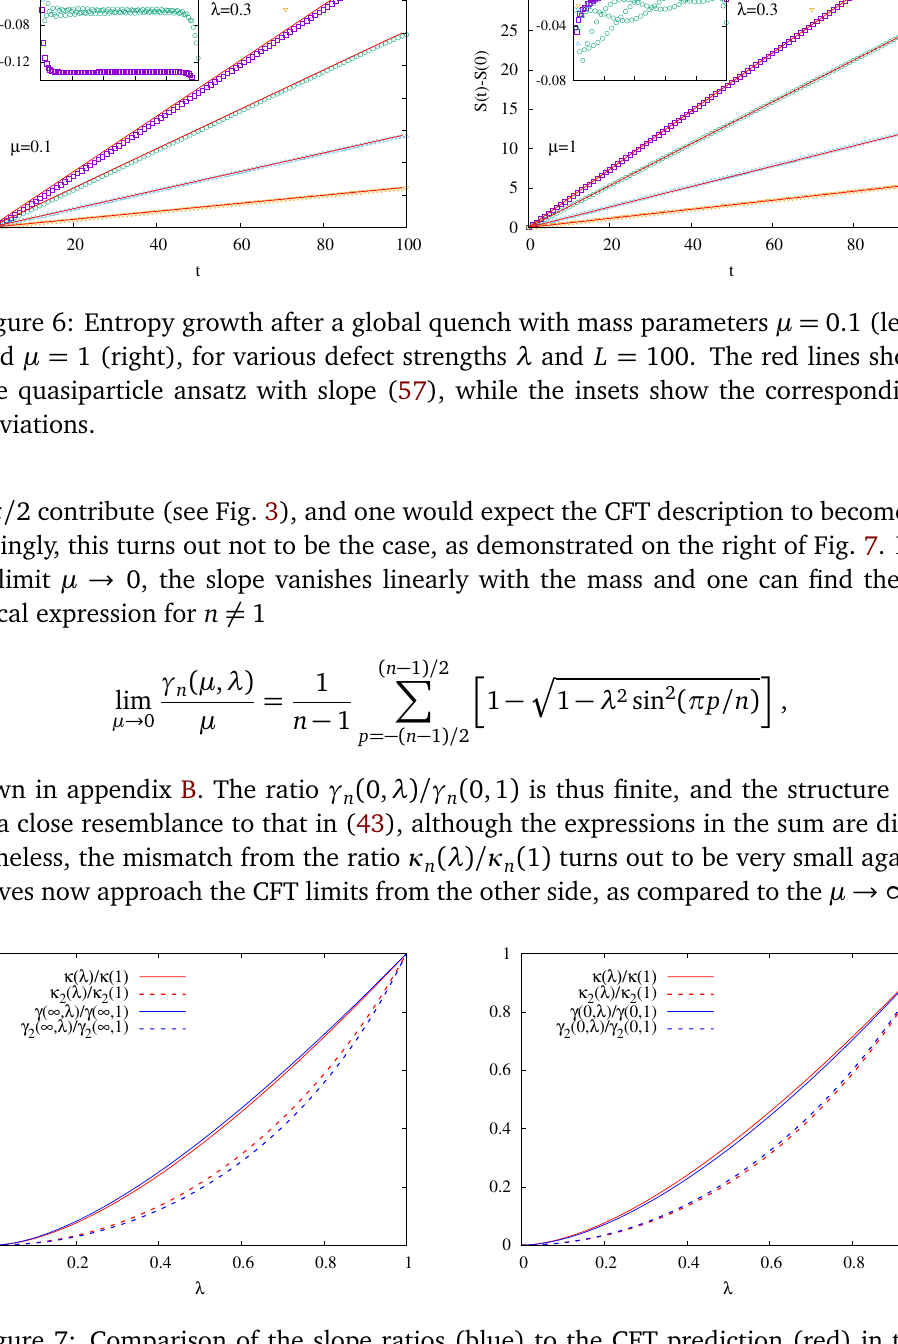
Figure 7: Comparison of the slope ratios (blue) to the CFT prediction (red) in the limits µ → ∞ (left) and µ → 0 (right), as a function of λ . The solid / dashed lines correspond to n = 1 and n =